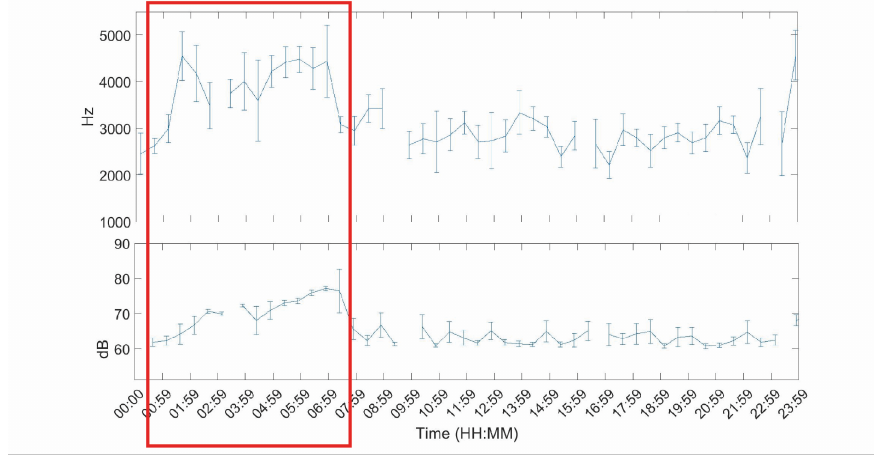
Figure 5. Temporal L eq sample in which the increase due to machinery is clearly identificable. In the horizontal axis we find the time and in the vertical axis the frequency ( top ) and the L eq ( bottom